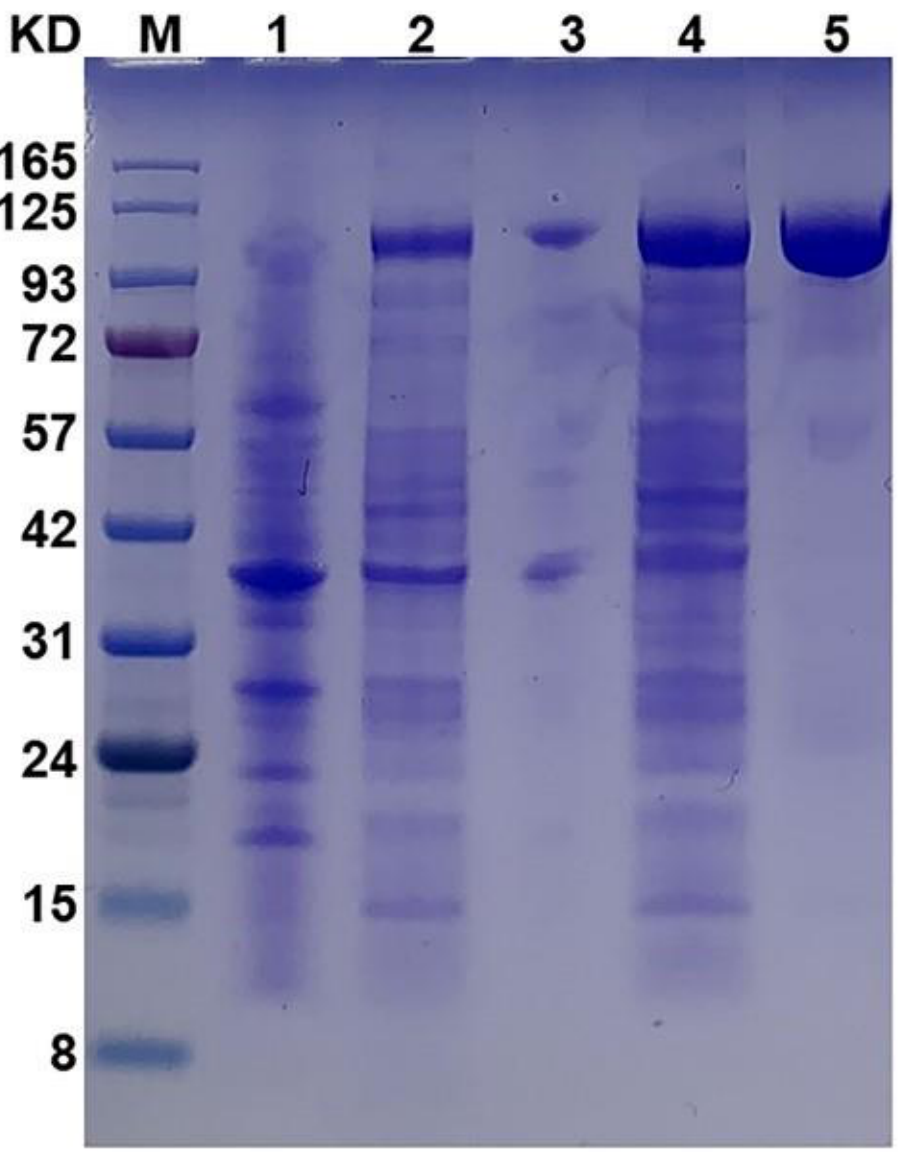
Figure 1. SDS-PAGE of Chon-ABC with 4–12% gradient. M: protein marker; Lane 1: cell lysate before induction; Lane 2: cell lysate after induction with IPTG; Lane 3: the supernatant after sonification; Lane 4: the precipitate after sonification; Lane 5: the purified Chon-ABC by Ni-NTA column.